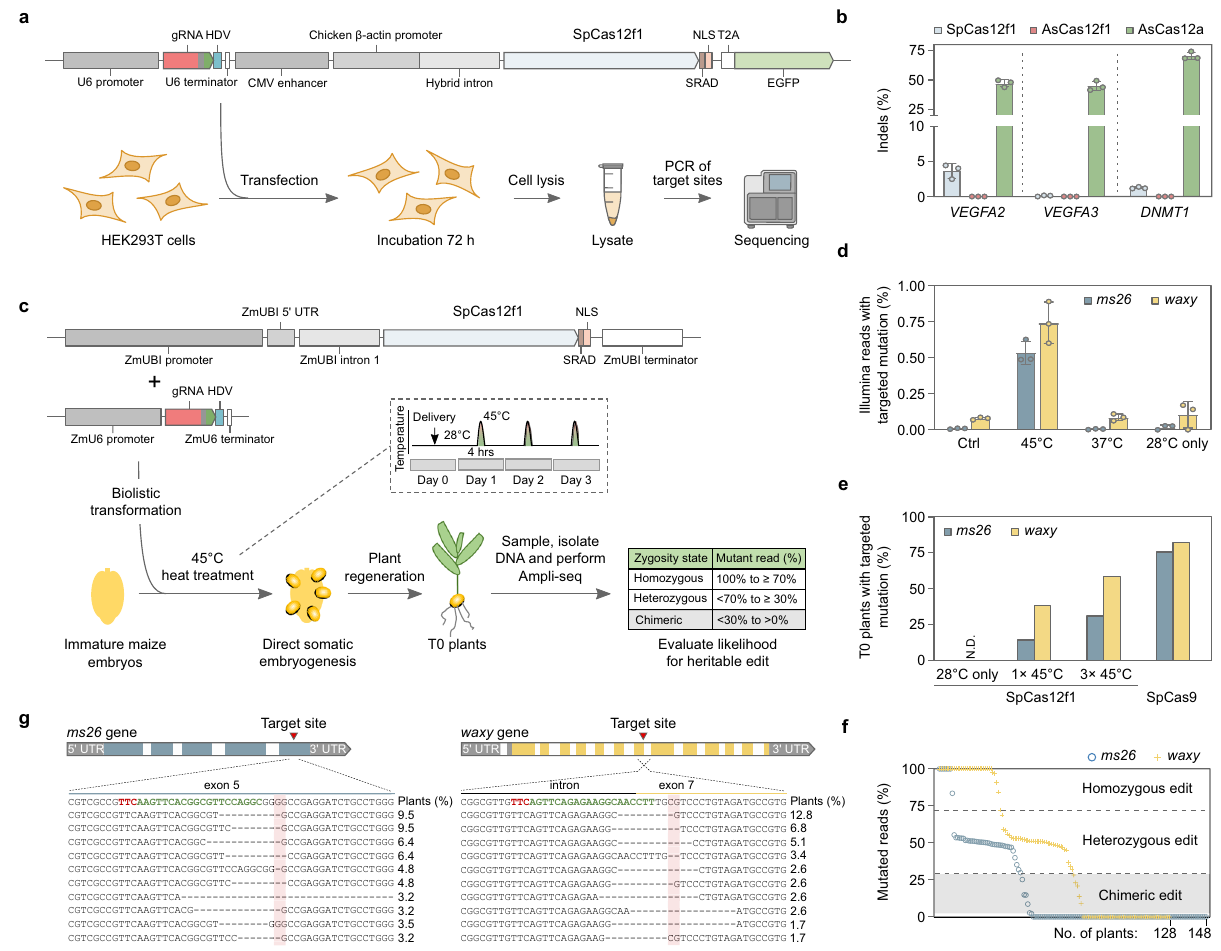
Fig. 3 SpCas12f1 in vivo activity in human (HEK293T) and maize ( Zea mays ) cells. a Overview of HEK293T genome editing experimentation. Cells were transfected with a DNA expression construct encoding Cas12f1 or AsCas12a and its corresponding gRNA. b Frequency of indels obtained 3 days after HEK293T transfection. As a control, experiments were also conducted with Acidaminococcus sp. BV3L6 (As) Cas12a. Bars represent mean values with ±SD (standard deviation) error bars and dots represent data for n = 3 independent biological replicates. c Overview of Zea mays genome editing assay. Expression constructs were delivered using biolistic transformation and short 4 h heat treatments applied 1, 2, or 3 days after transformation. T0 plants were evaluated for the likelihood of a heritable edit. d Indel frequencies recovered 3 days after transformation at 28 °C or with the application of three consecutive 4 h long heat treatments at either 37 or 45 °C. Control (Ctrl) experiments were performed by omitting the gRNA expression construct from transformation. Bars represent mean values with ±SD (standard deviation) error bars and dots represent data for n = 3 independent biological replicates. e Percentage of T0 plants predicted to contain a heritable ms26 and waxy targeted mutation. SpCas12f1 experiments were performed at 28 °C, with one (1 × 45 °C) or three (3 × 45 °C) 4 h 45 °C treatments. SpCas9 experiments were performed at 28 °C. f Predicted zygosity states of SpCas12f1 edited T0 plants. g Alignment of the 10 most abundant targeted indel mutations recovered in 3 × 45 °C SpCas12f1-edited T0 plants. The PAM is shown in red and protospacer target in green. The expected cut-site is indicated with red shading. Source data are provided as a Source data fi and AsCas12f1 (5 ’ -YTTN-3 ’ ) 1 . Expression plasmids encoding ternary SpCas12f1 and AsCas12f1:gRNA:dsDNA complexes showed a 2:1:1 stoichiometry, indicating that catalytically com- SpCas12f1 or AsCas12f1 nuclease and its gRNA were transfected (Fig. 3a) and after 72 h cells were harvested, and each site was assayed for the presence of mutations by targeted sequencing. All three SpCas12f1 target sites tested showed evidence of DNA double-strand break (DSB) repair as revealed by mutations cen- tered around the expected cut-site and ranged in frequency from 0.1 to 3.6% (Fig. 3b and Supplementary Fig. 11). For AsCas12f1, target cleavage could not be detected in HEK293T cells as tested